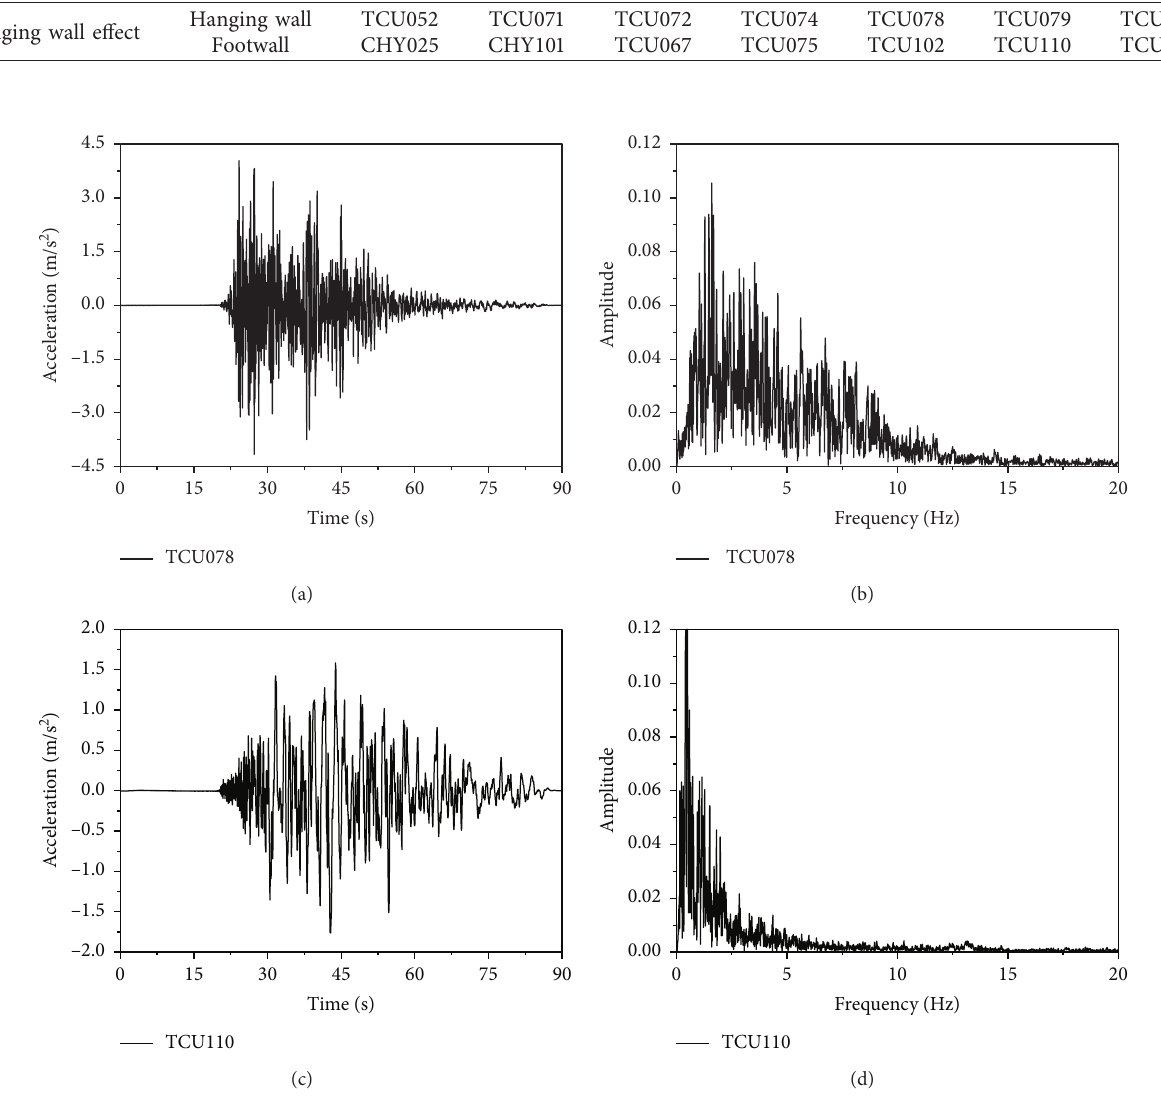
Figure 4: (a) The acceleration time-history of the wave from TCU078 station; (b) the corresponding Fourier spectra of the wave from TCU078 station; (c) the acceleration time-history of the wave from TCU110 station; (d) the corresponding Fourier spectra of the wave from TCU110